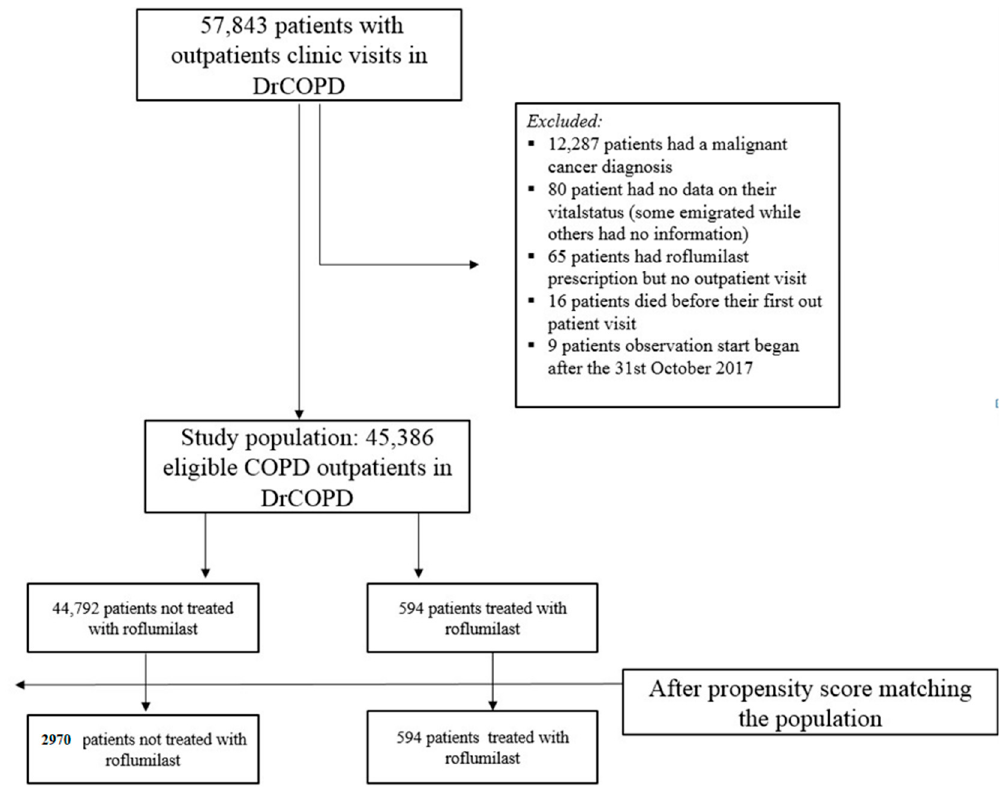
Figure 1. Participants population.